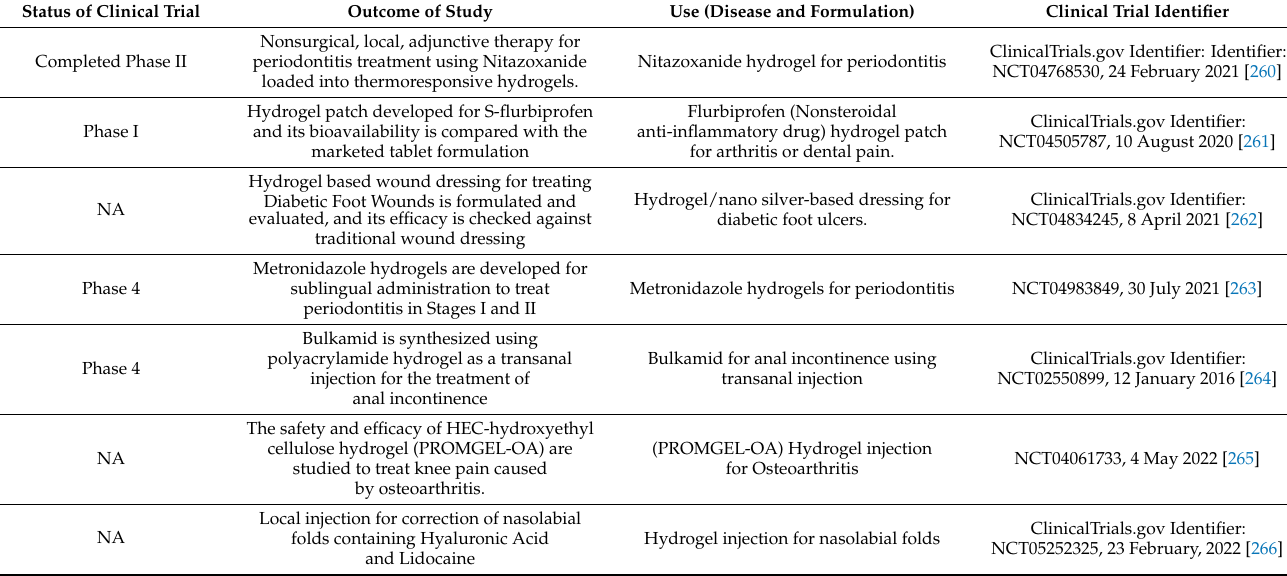
Table 8. Data on Clinical trials for thermoresponsive